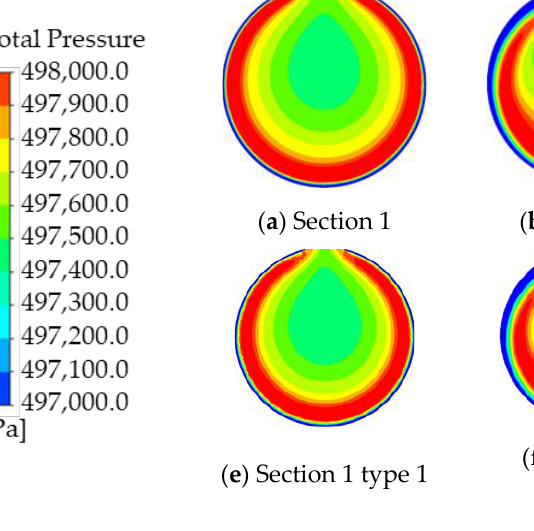
Figure 6. Velocity field in the central longitudinal section of the inlet pipe. The full pressure plots and the flow line structure from the first radial section (39.7°) to the third one (129.7°) are virtually identical in all variants considered. Starting from the third section (129.7°), the full pressure distribution depends on the fin type. Installing a fin №1 results in the emergence of an edge trail and an increased radial and edge unevenness. The resistance coefficient of an inlet pipe with fin №1 is 10.2% higher than the resistance coefficient of an inlet pipe without fins. The turbulence kinetic energy in the fourth and fifth (from 174.7 to 219.7°) radial sections of the inlet pipe with a fin is higher by 13 and 17%, respectively. Therefore, installing a longitudinal flat fin in the center of a volute inlet pipe does not provide any positive effect (type 1). Our analysis of the flow line structures, as shown in Figure 7, in inlet pipes with two symmetrical fins (type 2) has demonstrated that installing two fins, as well as installing a single longitudinal fin, does not eliminate the vortex formation from the third (129.7°) to the fifth (219.7°) radial sections. The resistance coefficient of an inlet pipe with fin №2 is 14.8% higher than the resistance coefficient of an inlet pipe without fins. Using two symmetrical rounded fins (type 3) allows virtual elimination of the paired vortices and to stabilize the flow. However, the resistance coefficient of an inlet pipe with fin №3 is 15% higher than the resistance coefficient of an inlet pipe without fins. Using two symmetrical short fins in the flow (type 4) does not eliminate the vortex formation, as shown in Figures 8 and 9, from the third (129.7°) to the fourth (174.7°) sections. However, starting from the fifth (219.7°) section, vortices are virtually absent. In all cases, the use of fins improves the flow evenness starting from the sixth radial section (264.7°). The qualitative assessment of the vortex structure in the third and fifth sections allows us to conclude that the least vortex formation is achieved in the inlet pipe with two symmetrical short fins in the flow (type 4).